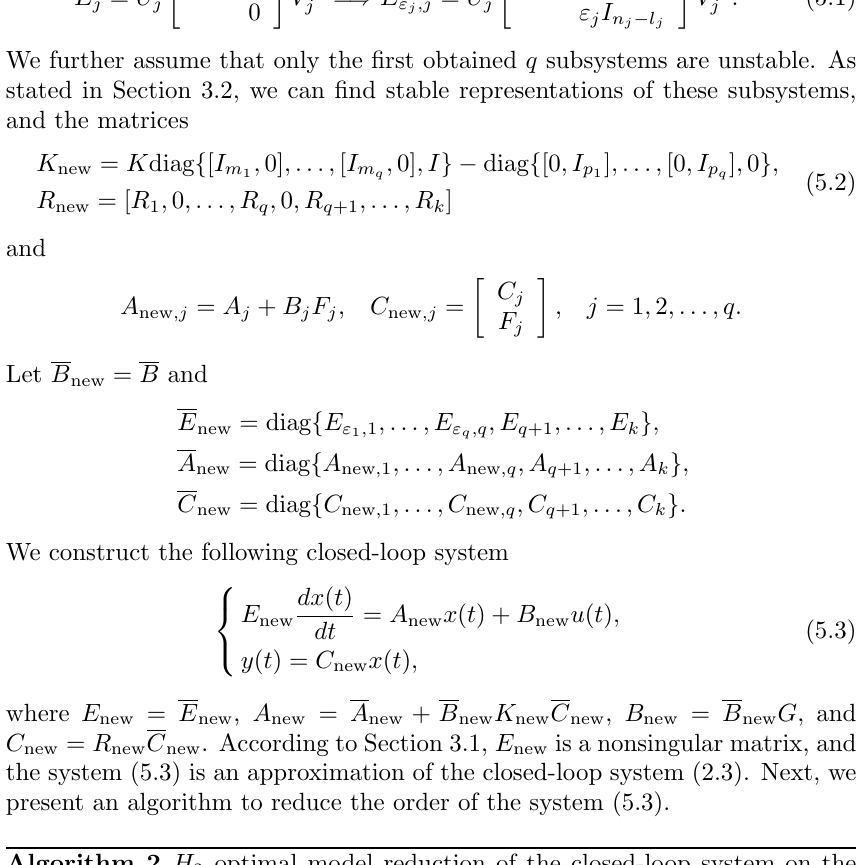
Algorithm 2 H 2 optimal model reduction of the closed-loop system on the Grassmann